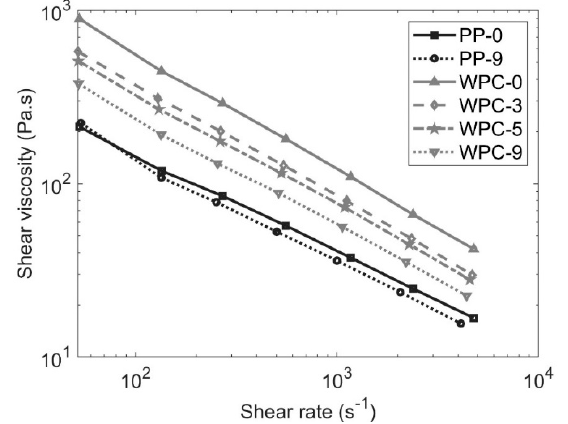
Figure 4. Shear viscosity curves for polypropylene (PP) and WPC before recycling and after recycling at 230 °C.